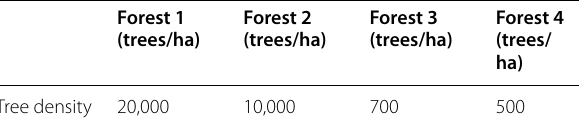
Table 4 Tree density for the 4 different forest scenario Forest 1 (trees/ha)